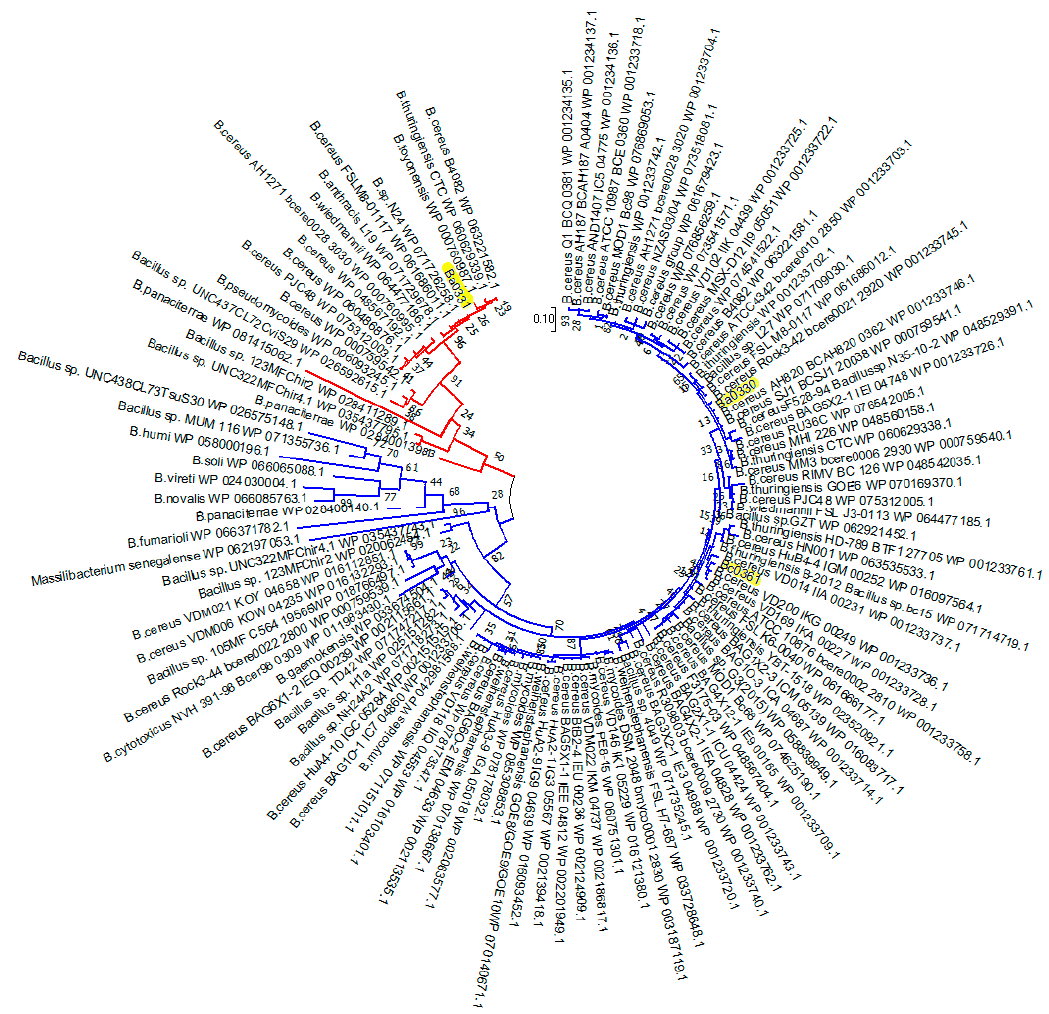
Figure 3. Molecular Phylogenetic analysis of the PDA Fn3 domain. The unrooted tree of 117 amino acid sequences of the PDA Fn3 domain by the Maximum Likelihood method is shown. The tree with the highest log likelihood ( − 10,732.65) is shown. The sequences are clustered in two distinct groups (Ba0330 like (blue) and Ba0331 like (red). Ba0330, Bc0361 and Ba0331 are highlighted in yellow. Sequences are from the Bacilii species that have been found to contain PDAs with the Fn3 domain. Most of the PDAs of B. anthracis and B. cereus contained the CE4 NodB catalytic domain towards the C-terminal, except for Ba3480, where the NodB domain was located between amino acid residues 295 and 491, in a total of 927. Enzyme-specific active site residues were highly conserved within the sequences of the NodB domain. They were also conserved in position in the 3D structures. In detail, three out of the five known sequence motifs associated with catalysis (MTs) [25] were conserved in all groups along the amino acid sequence. MT1 retained the sequence TFDDG, except for Ba3943 and Ba0150; MT2 with H(S/T)x(N,T,S)H, except in Ba0150; MT3 with (R/A) pPxG; and MT4 with Wxx (D,E) xxDW for Groups 2 and 3. For Group 1, MT4 became MT4 ′ with R (H,V) (R,F) located 15 residues further along the sequence. The sequence motif MT5 for Groups 2 and 3 was (I,V)(I,V)L(L,M,Q)H while for Group 1 proteins, the MT5 ′ LMYH was located in the N-terminal side of the NodB domain sequence (Figure 4 and Supplementary Figure S4). Irrespective of the shifted location of the MT4 (cid:48) and MT5 (cid:48) motifs in the sequence, their positions were conserved among the 3D structures of the compared enzymes (Figure